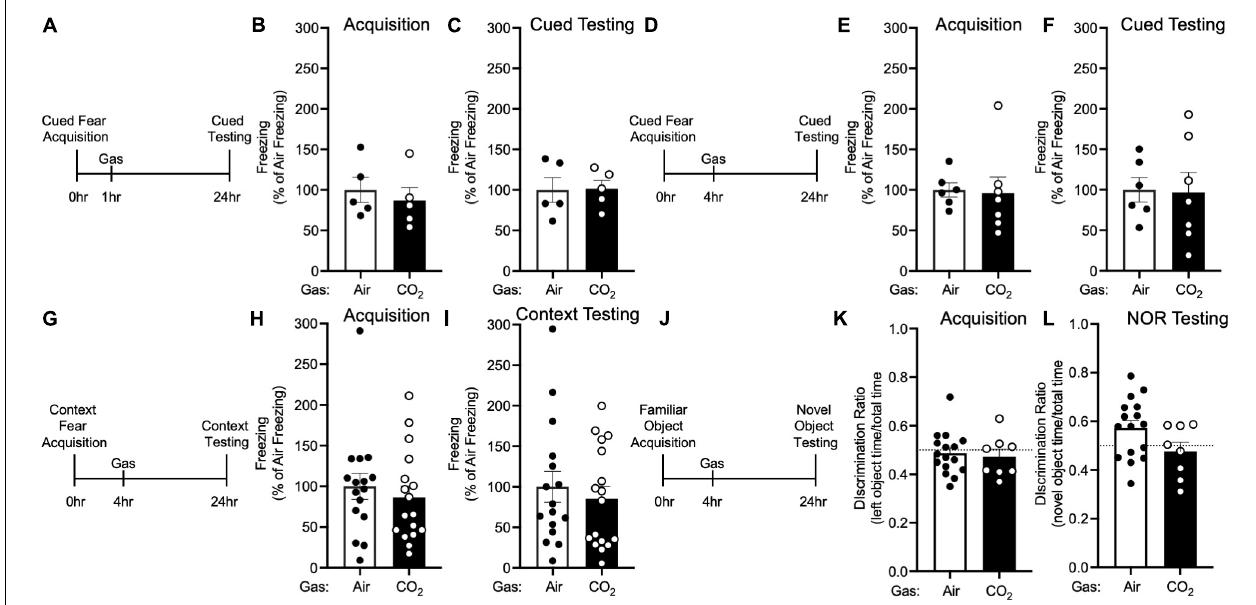
FIGURE 4 | The effects of CO 2 Inhalation on fear memory depend on ASIC1A. (A) Experimental timeline. 1 h after cued fear acquisition, Asic1a − / − mice were exposed to air or 10% CO 2 for 30 min. 24 h after acquisition, cued fear memory was assessed. (B,C) Prior to gas exposure, freezing during acquisition prior to gas exposure did not differ between air and 10% CO 2 -treated groups (B) [ t (8) = 0.5867, p = 0.5736, n = 5/group] nor did freezing after gas exposure during the cued fear test (C) [ t (8) = 0.07644, p = 0.9409]. (D) Experimental timeline. 4 h after cued fear acquisition, mice were exposed to air or 10% CO 2 for 30 min. 24 h after acquisition, cued fear memory was assessed. (E,F) Freezing during acquisition prior to gas exposure did not differ between air and 10% CO 2 -treated groups (E) [ t (11) = 0.1697, p = 0.8683, n = 6, 7] nor did freezing during the cued fear test (F) [ t (11) = 0.1077, p = 0.9162]. (G) Experimental timeline. 4 h after context fear acquisition, mice were exposed to air or 10% CO 2 for 30 min. 24 h after acquisition, context fear memory was assessed. (H,I) Freezing during acquisition did not differ between air and 10% CO 2 -treated groups (H) [ t (31) = 0.6410, p = 0.5262, n = 16, 17] nor did freezing during the context fear test (I) [ t (31) = 0.5469, p = 0.6091]. (J) Experimental timeline. 4 h after novel object acquisition, mice were exposed to air or 10% CO 2 for 30 min. (K) Prior to gas exposure, object preference during acquisition prior to gas exposure did not differ between air and 10% CO 2 -treated groups [ t (22) = 0.3543, p = 0.7265, n = 16, 8] and neither air [ t (15) = 0.6143, p = 0.5482] nor 10% CO 2 -treated [ t (7) = 0.8899, p = 0.4031] groups preferred the left or right objects. (L) A trend toward a reduction in discrimination between the novel and familiar objects was observed in 10% CO 2 -treated mice [ t (22) = 1.878, p = 0.0737]. Novel object preference was observed